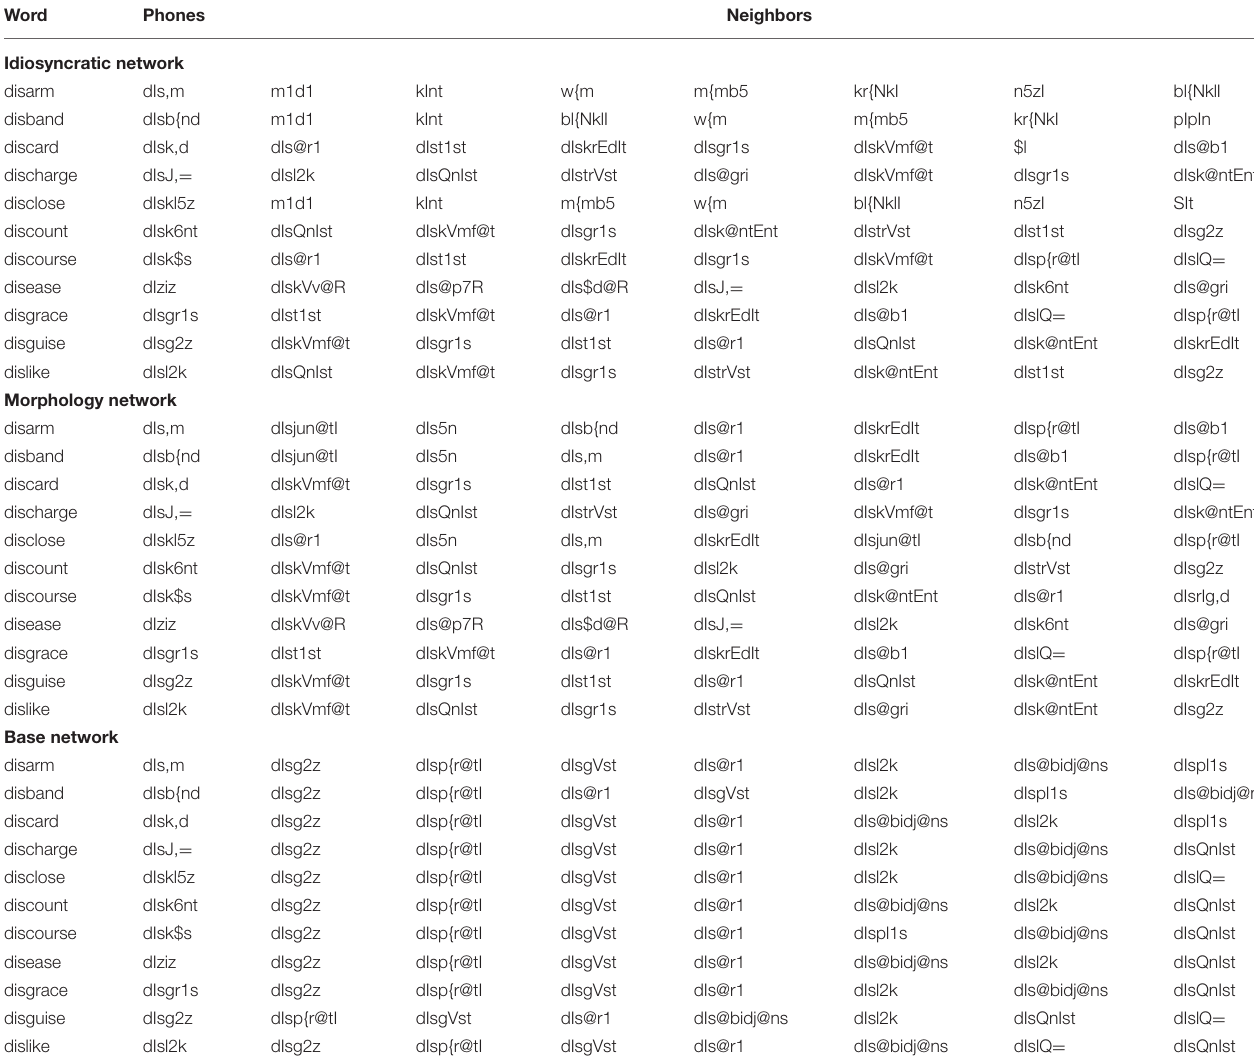
TABLE 7 | Extract from the closest semantic neighbors of DIS words in the three